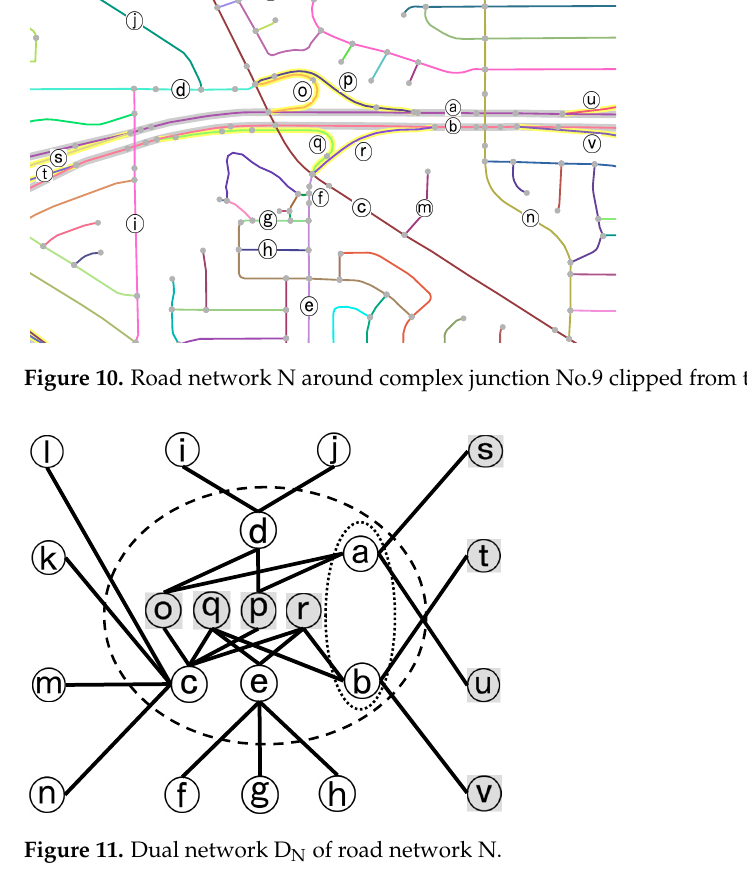
Figure 10. Road network N around complex junction No.9 clipped from the test data.